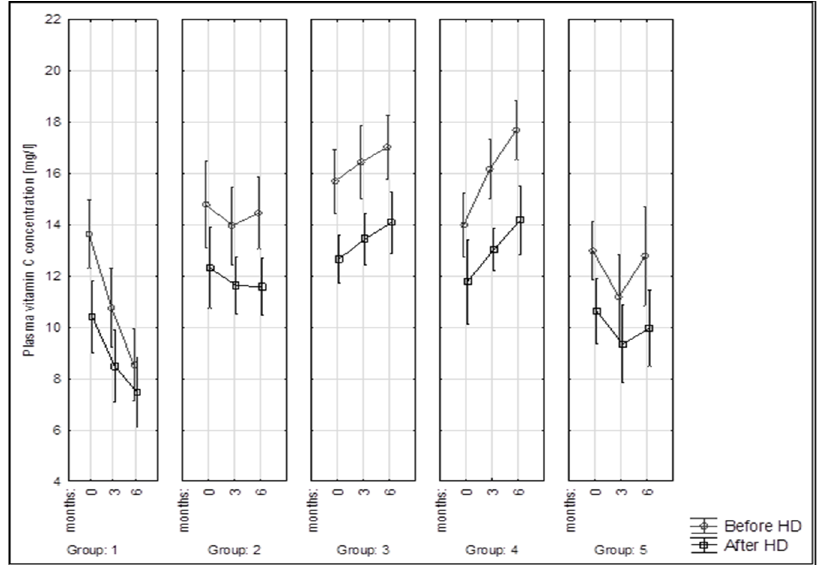
Figure 3. Changes in vitamin C concentration (mg/L) in examined groups of patients during 6 months of the study.